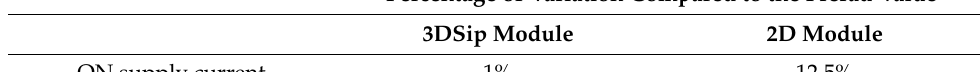
Table 3. Percentages of variation compared to the prerad values of parameters at 400 krad(Si) (X-rays